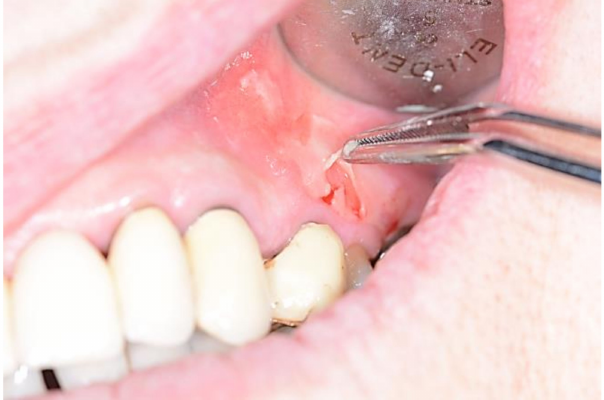
Figure 6. Nikolsky sign positivity in patient with pemphigus vulgaris.